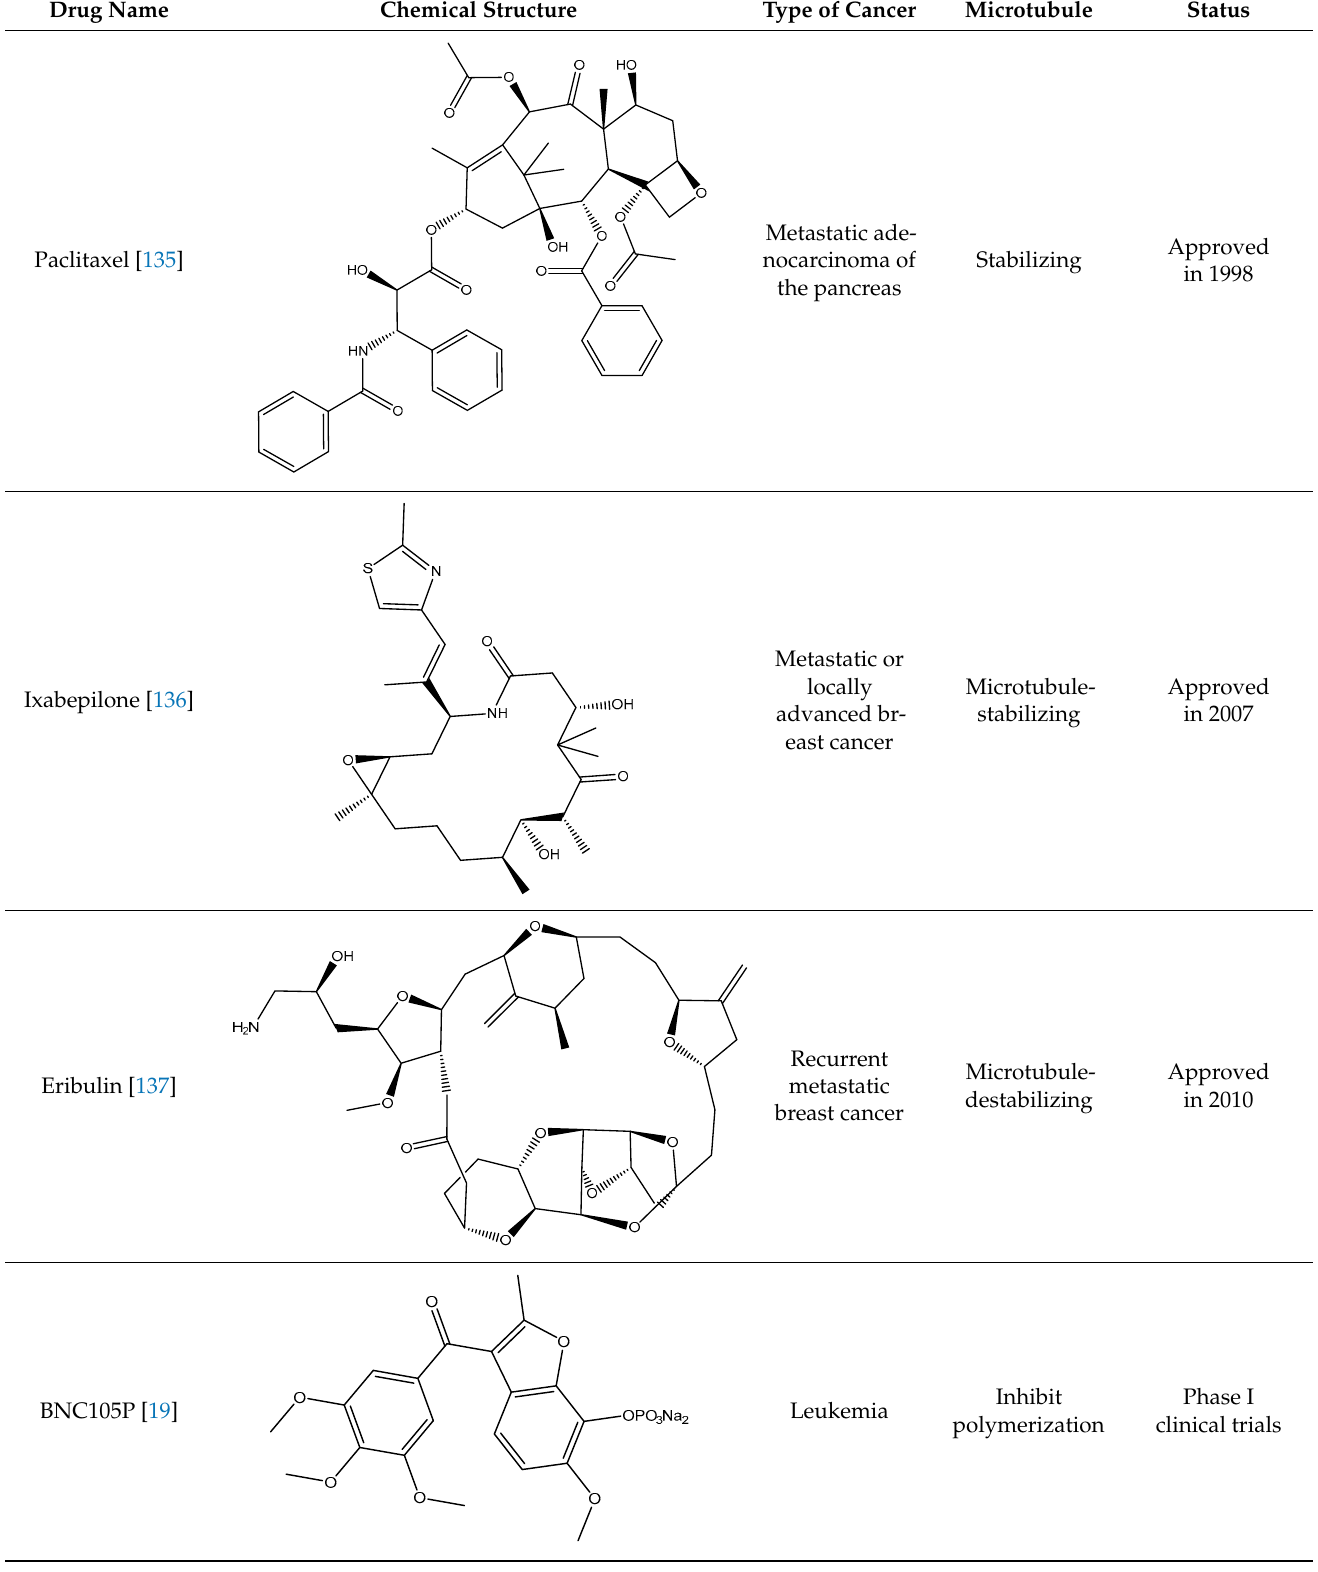
Table 1. List of tubulin inhibitors in clinical developments or approved by FDA.